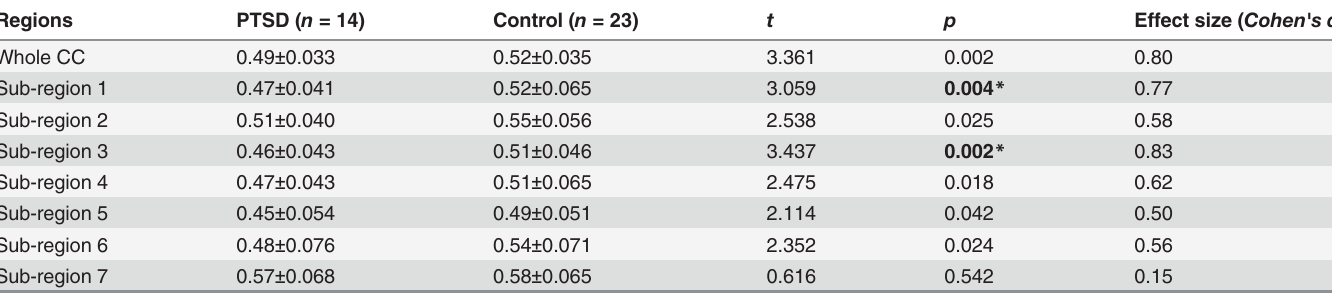
Table 4. Mid-sagittal fractional anisotropy values of the region of interest (ROI) in corpus callosum (Mean ± SD).